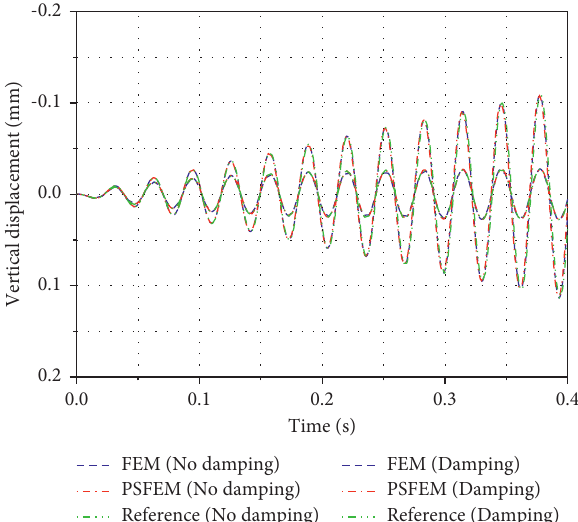
Figure 14: Time history of the vertical displacement.